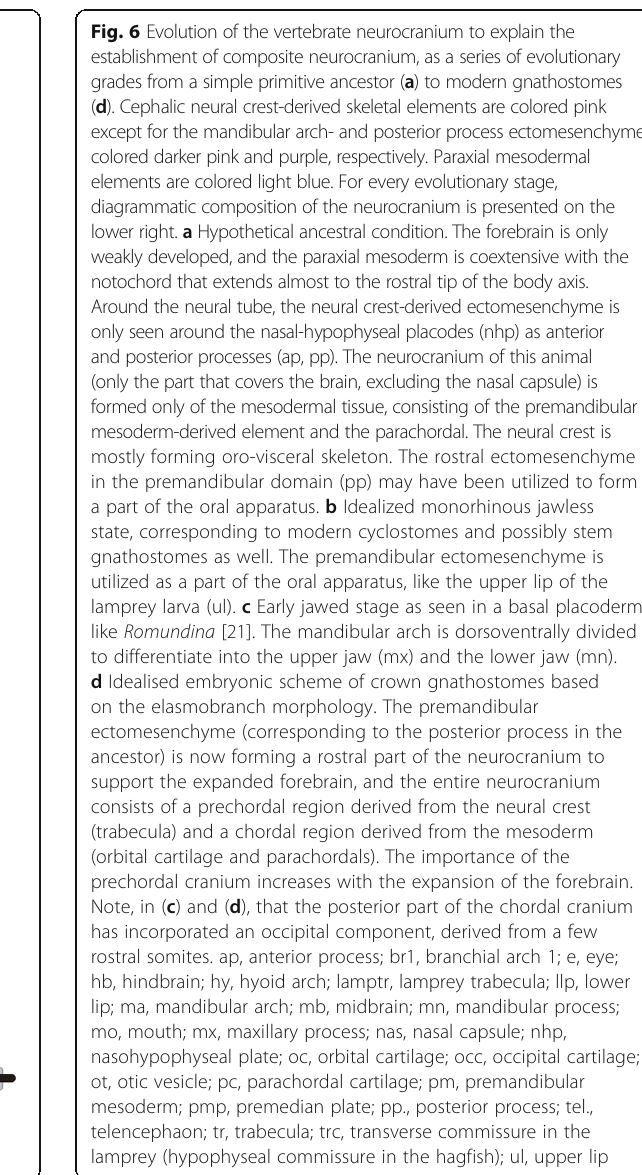
It seems that the origin of the crown gnathostome tra- beculae involved several steps and provides an example of how a seemingly trivial anatomical modification can open the door to major morphological change. In a cyclostome, the forebrain cavity is floored only by the soft dorsal wall of the nasohypophyseal duct. The first step in the origin of the trabeculae, starting perhaps already in galeaspids but brought to completion in early placoderms, was the re-routing of at least part of the premandibular ectomesenchyme into the space between the hypophyseal and nasal placodes. This obliterated the nasohypophyseal duct (although the buccohypophyseal foramen can be considered a remnant of its ventral